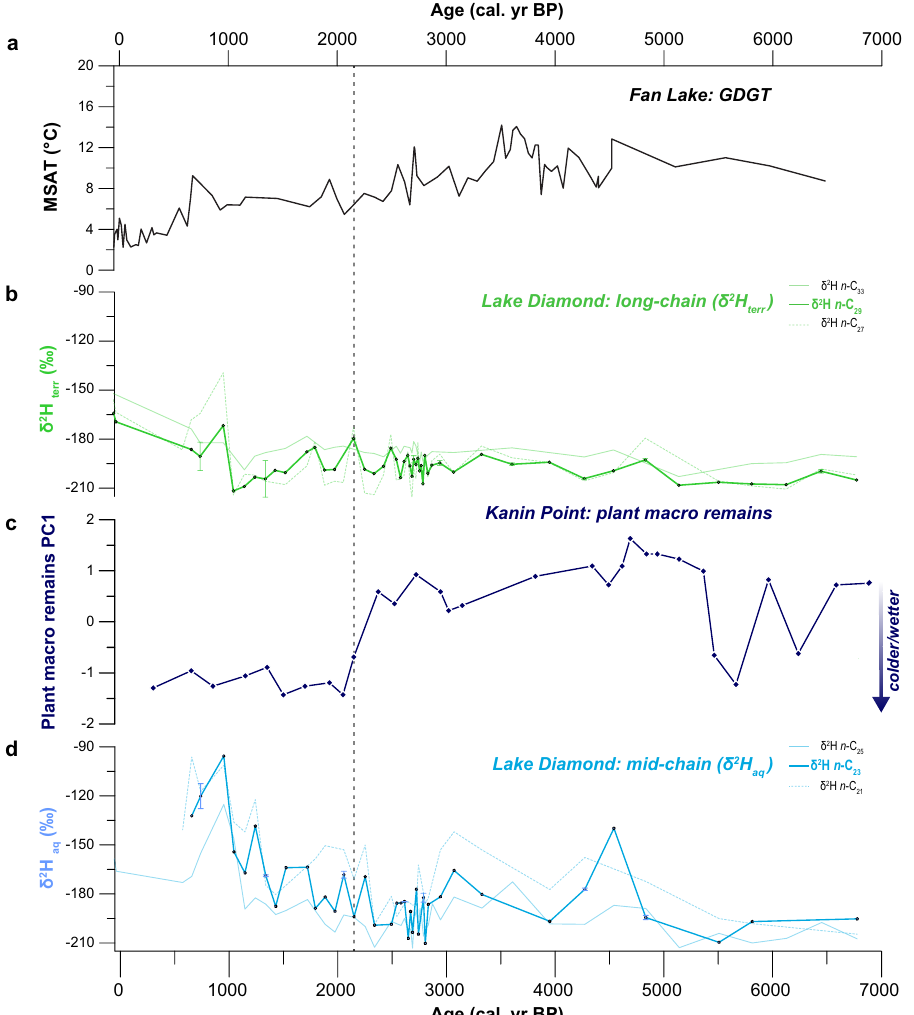
Fig. 6 Comparing compound-speci fi c hydrogen isotope values ( δ 2 H) from Lake Diamond with local temperature and hydroclimate proxies. a GDGT- derived mean summer air temperatures (MSAT) from neighboring Annenkov Island 27 . b Terrestrially produced long-chain n -alkane δ 2 H values from Lake Diamond (this study), highlighting representative C 29 homolog. c Principal component analysis (PCA) of plant macrofossil data from ref. 69 . d Aquatically sourced short-chain n -alkane δ 2 H values from Lake Diamond (this study), highlighting representative C 23 homolog. The ~2150 cal. yr BP age where change- point analysis detects a signi fi cant deviation from the long-term mean is shown by a stippled line. All color coding matches that of Figs. 3 –